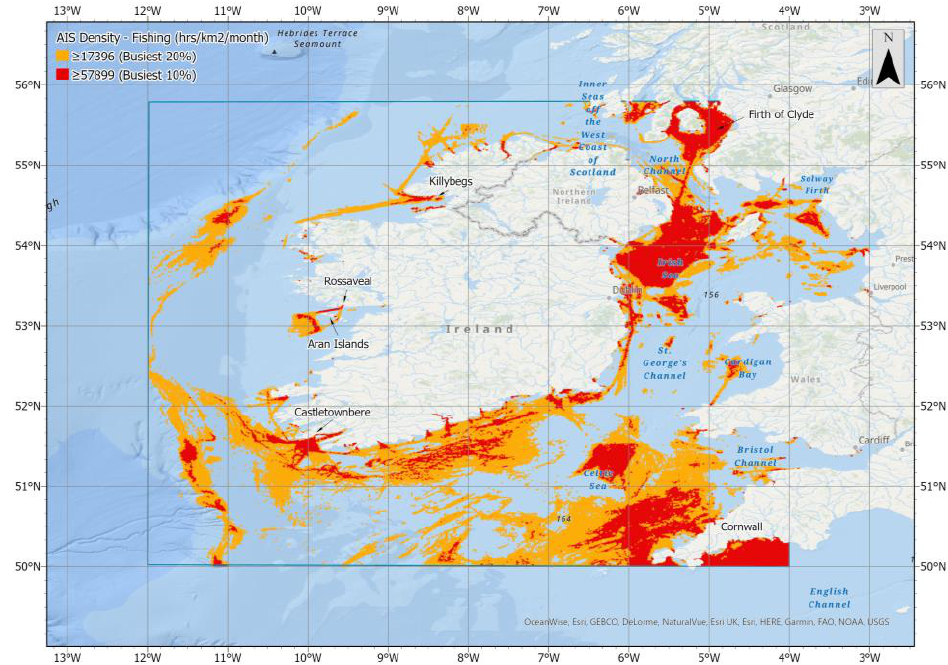
Figure 18. The busiest 1.5% (orange) and 1% (red) areas for shipping in the Selkie study area based on a three-year time series of AIS data (h/km 2 /month).